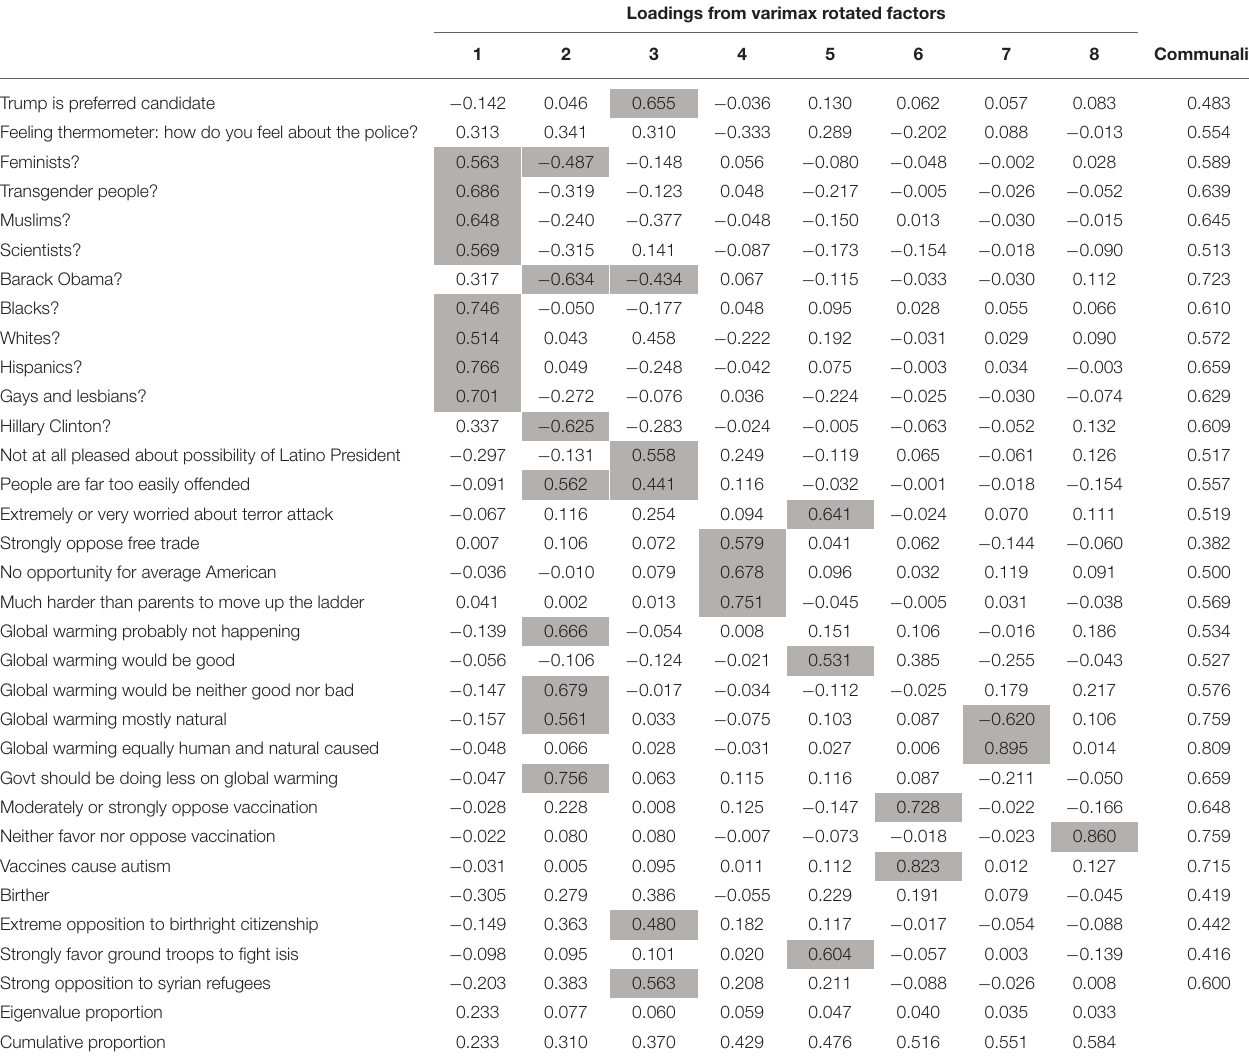
Loadings from varimax rotated